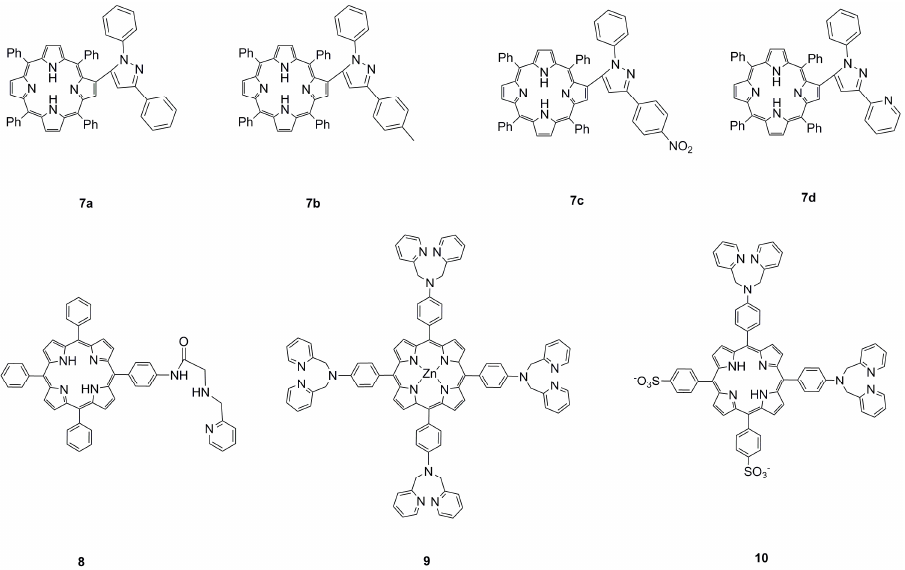
Figure 2. Structural formula of porphyrins modified with pyrrole, pyrazole, and pyridine. Reproduced from ref [31,33,84,85].